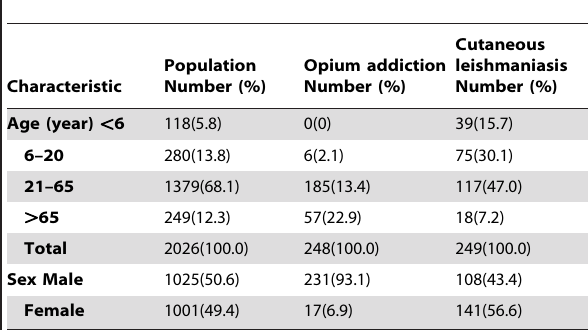
Table 1. Baseline characteristics of study